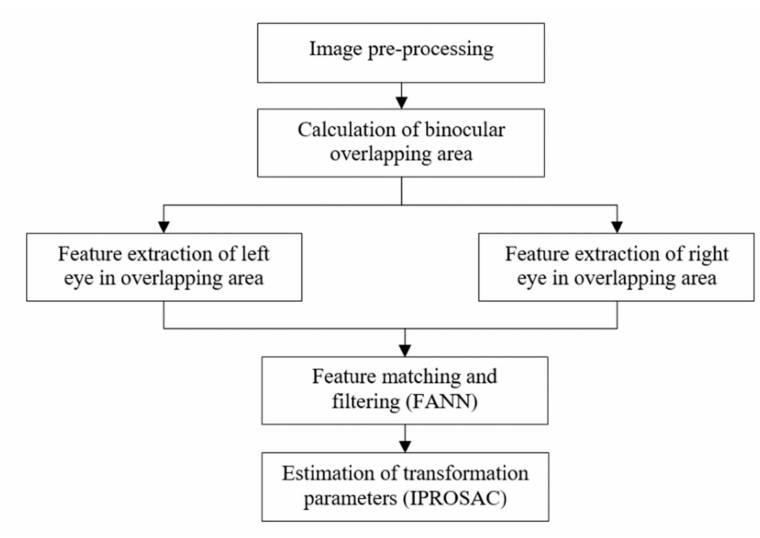
Figure 10. The stereo matching algorithm for binocular